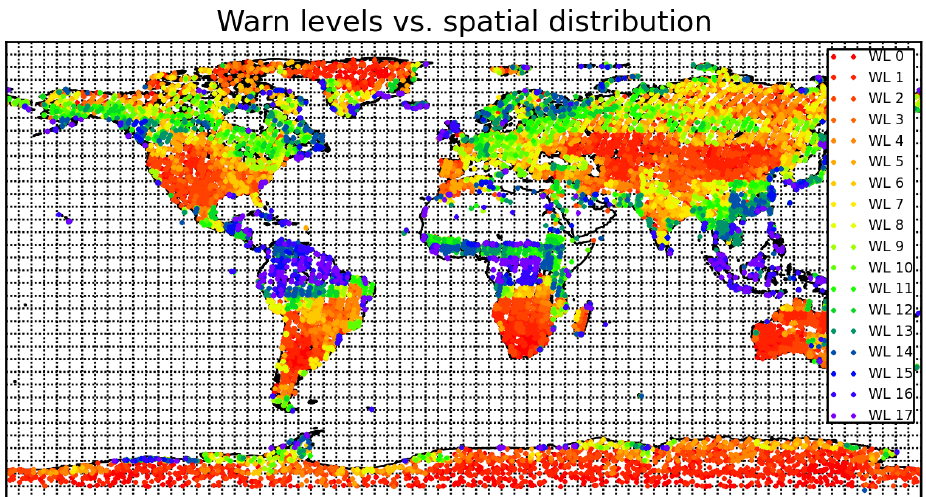
Fig. 15. Selector spatial coverage, color-coded by worst selected warn levels required for each five degree latitude region for an example 20% transparency setting using actual GOSAT data (full data set). Note that cloudy regions near the equator and highly mixed terrain such as shorelines are more problematic than large, flat regions. The unfilled regions in Africa and the Arabian Desert are due to the omission of M gain data from this analysis. Warn Level 18 & 19 are never permitted to be selected, as they are too confounded to be useful for later analysis.